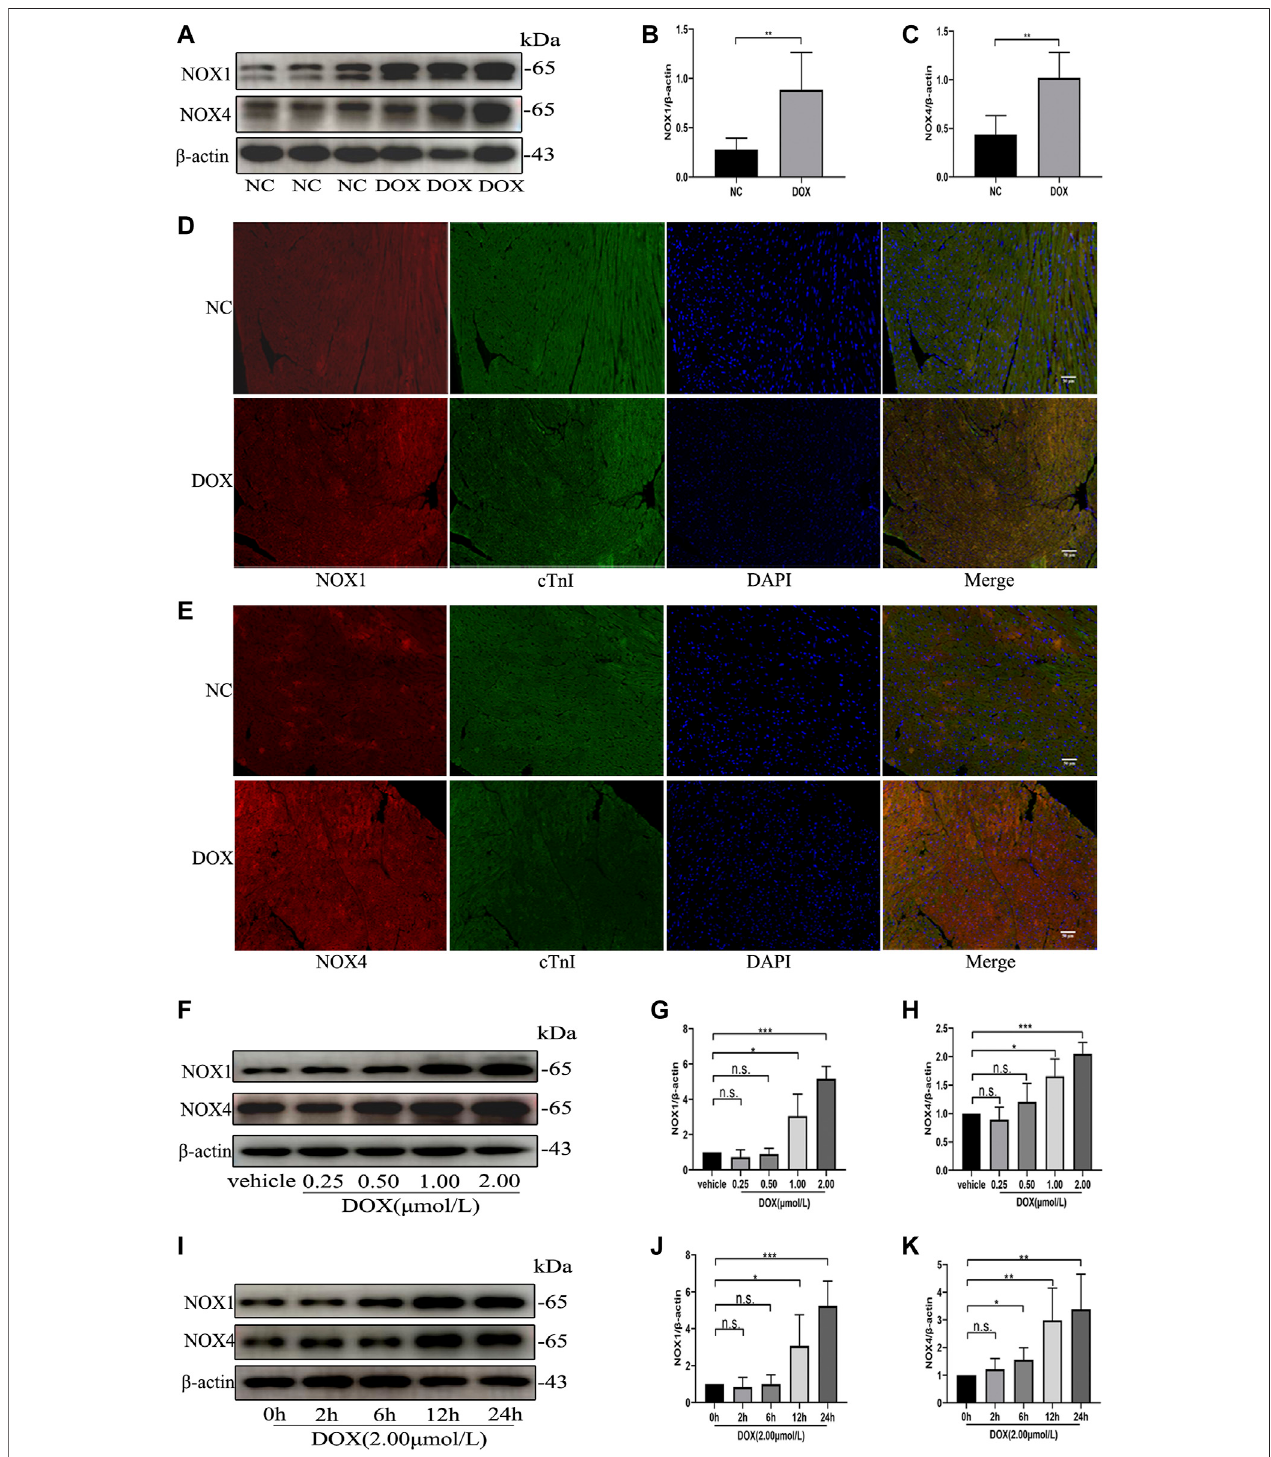
FIGURE 1 | The protein levels of NOX1 and NOX4 were increased by DOX both in vivo and in vitro . (A) Representative western blot analysis of NOX1 and NOX4 in myocardial tissue. (B,C) Quanti fi cation of NOX1 and NOX4 expression relative to the β -actin level ( n = 6 per group). (D,E) Representative images of NOX1 and NOX4 expressioninmyocardialtissuedetectedbytheimmuno fl uorescence.ThenucleiwerestainedwithDAPI(Scalebar=50 µm). (F) Representativewesternblotanalysisof NOX1 and NOX4 of NRCMs treated with DOX of different concentrations for 24 h (G,H) Quanti fi cation of NOX1 and NOX4 expression relative to the β -actin level ( n = 3). (I) Representative western blot analysis of NOX 1 and NOX 4 of NRCMs treated with DOX for different time. (J,K) Quanti fi cation of NOX1 and NOX4 expression relative to the β -actin level ( n = 4 – 5). * p < 0.05, ** p < 0.01, *** p < 0.001, n. s., not signi fi cant. NOX, NADPH oxidase; DOX, doxorubicin; cTnI, Cardiac troponin I.